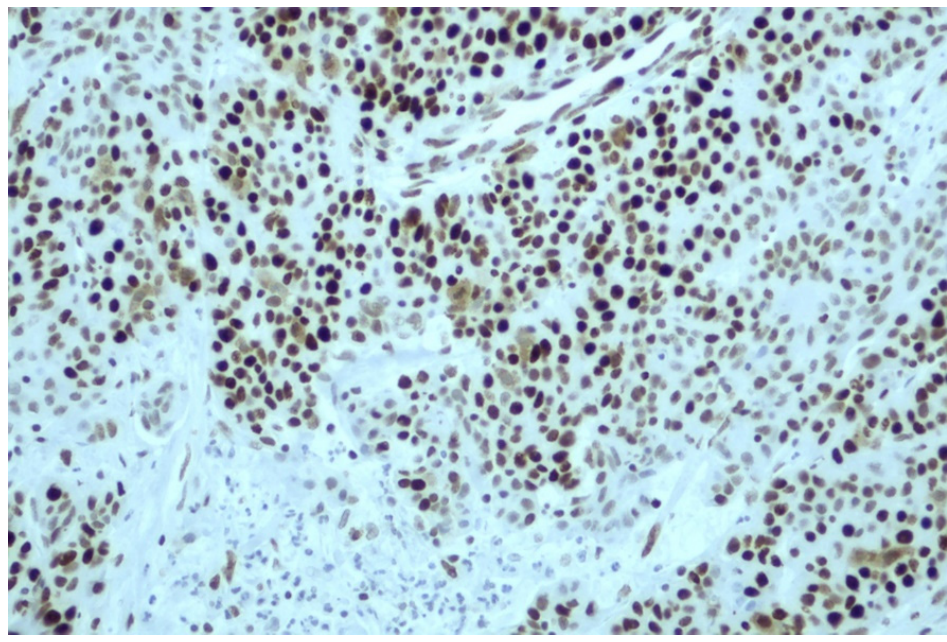
Figure 4. Immuno-histochemical staining of MSH2 in concordance with the results of the fragment analysis.